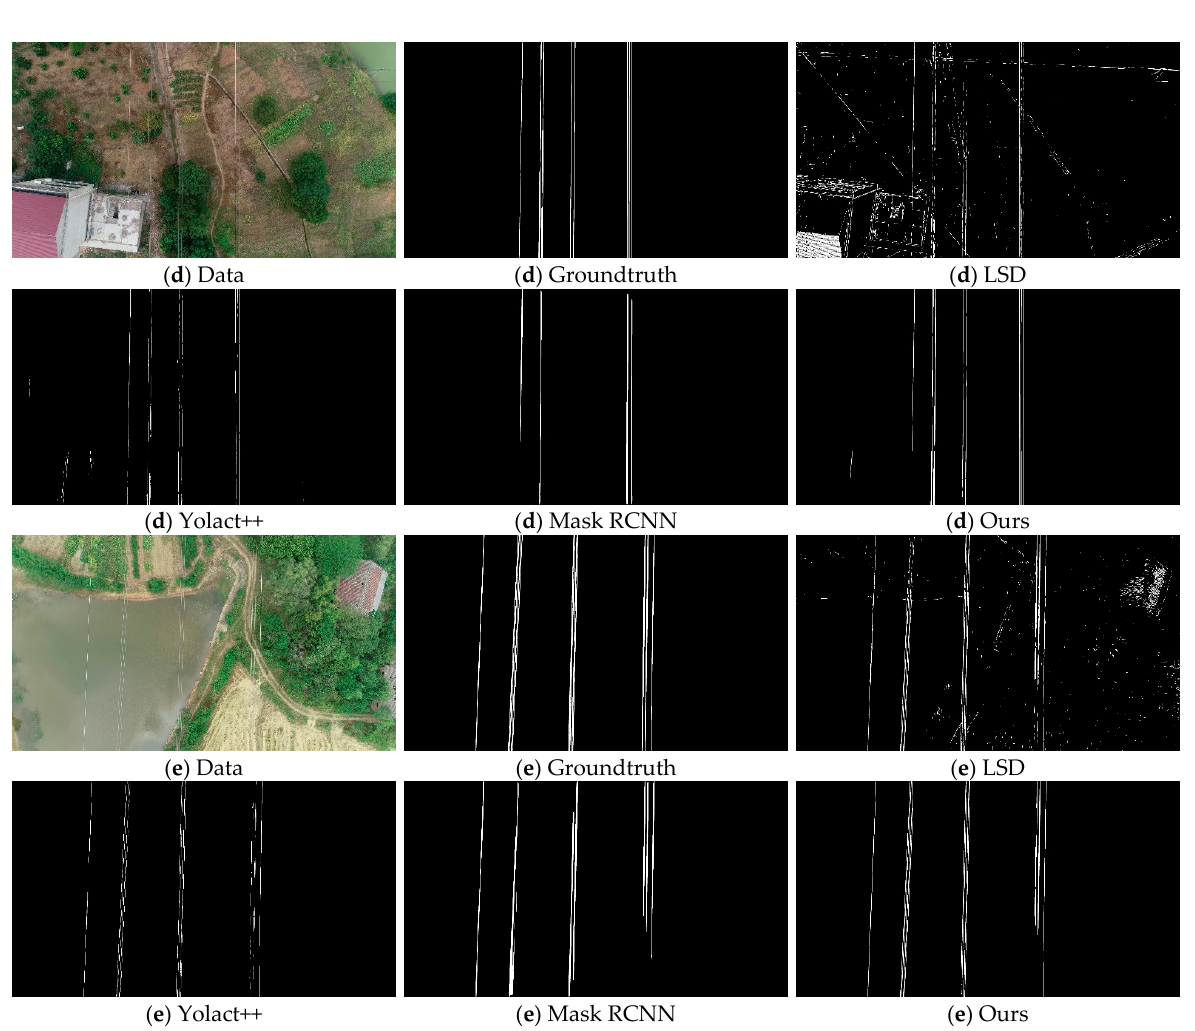
Figure 9. The extraction results of various methods on the test dataset. The extraction results are shown for five scenes, namely ( a – e ). A total of six images are shown for each scene, which are the input image (Data), the truth image (Groundtruth), and the extraction results of four methods (LSD, Yolact++, Mask RCNN, and Ours).